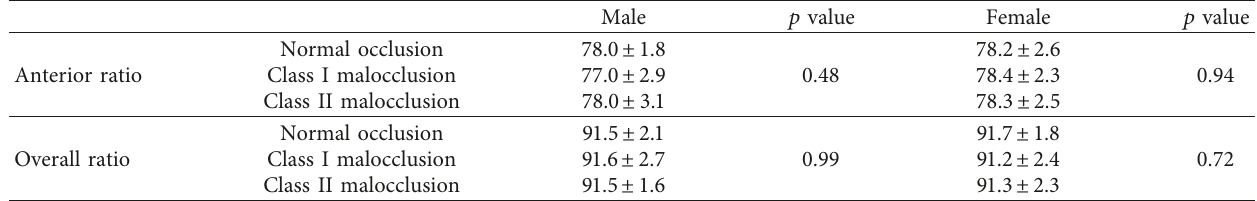
Table 5: Comparison of Bolton’s anterior and overall ratios as a function of sex and Angle’s